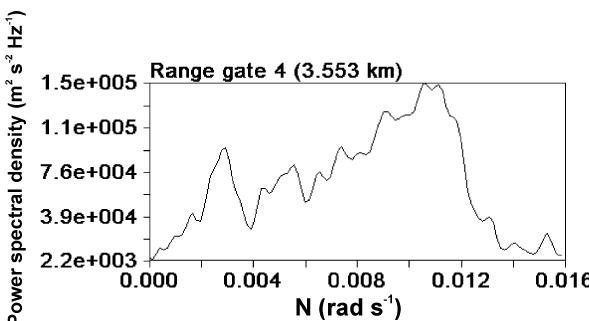
Fig. 8. Same as Fig. 7 with reference values between 5 and 11km.